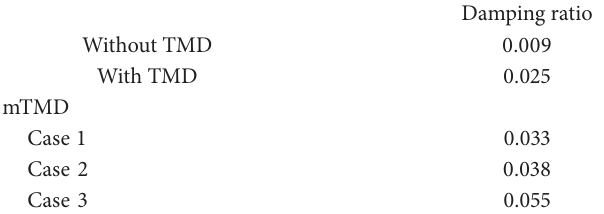
Table 4: Comparison of damping